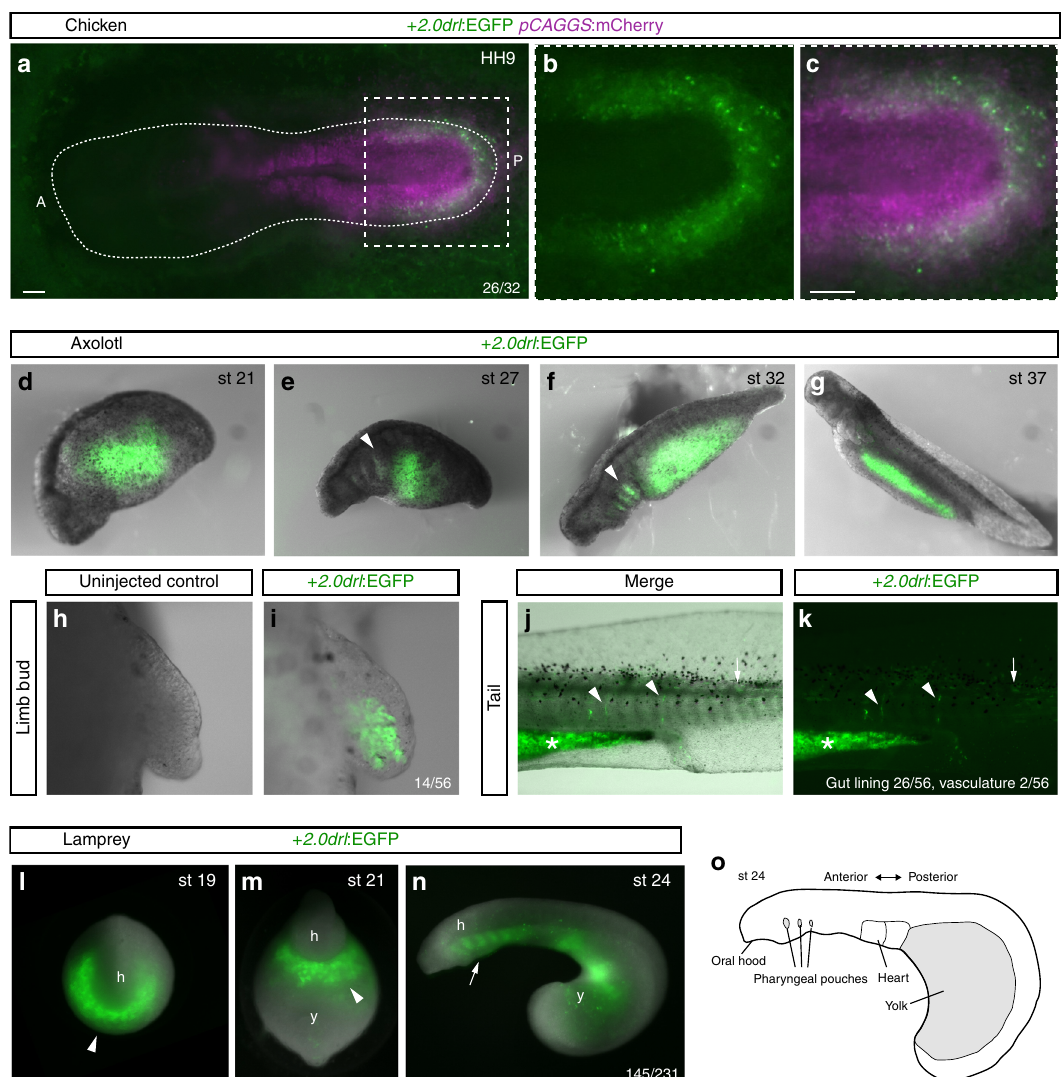
Fig. 6 The zebra fi sh + 2.0 drl enhancer reads out a LPM program across vertebrates. a – c Representative HH9 ex-ovo-cultured chicken embryo electroporated at HH3 + /4 with + 2.0drl :EGFP (green, a – c ) and ubiquitous pCAGGS:mCherry control (magenta, a , c ), showing speci fi c + 2.0drl reporter expression in the electroporated LPM ( n = 26/32). The dashed line depicts the outline of the chicken embryo, anterior (A) to the left, posterior (P) to the right; boxed region ( a ) depicts magni fi ed area shown for single and merged channels ( b , c ). d – k Expression of + 2.0 drl :EGFP upon transient injections in axolotl at the indicated embryonic stages. Note EGFP expression in the lateral portion of the embryo, future gut region, and pharyngeal arches (arrowheads in e , f ). h , i EGFP expression in mesenchymal cells of the developing axolotl limb bud, indicative of LPM origin ( n = 14/56). j , k EGFP fl uorescence in axolotl st 43 larvae in the gut lining (asterisk, n = 26/56) and blood vessels (arrowheads, n = 2/56). Expression is also found occasionally in a small fraction of muscle fi bers (arrows). l – o Transient transgenic lamprey embryos ( Petromyzon marinus ) with + 2.0drl :EGFP expression in the anterior mesendoderm (arrowheads) and overlying the yolk at neurula stages (st 19 – 21) ( l , m ), and in the developing pharynx (arrow) during head protrusion (st 23 – 24) ( n ); views anterior ( l ), ventral ( m ), lateral ( n ), head (h) and yolk (y) ( n = 145/231). o Schematic depiction of st 23 lamprey embryo to outline